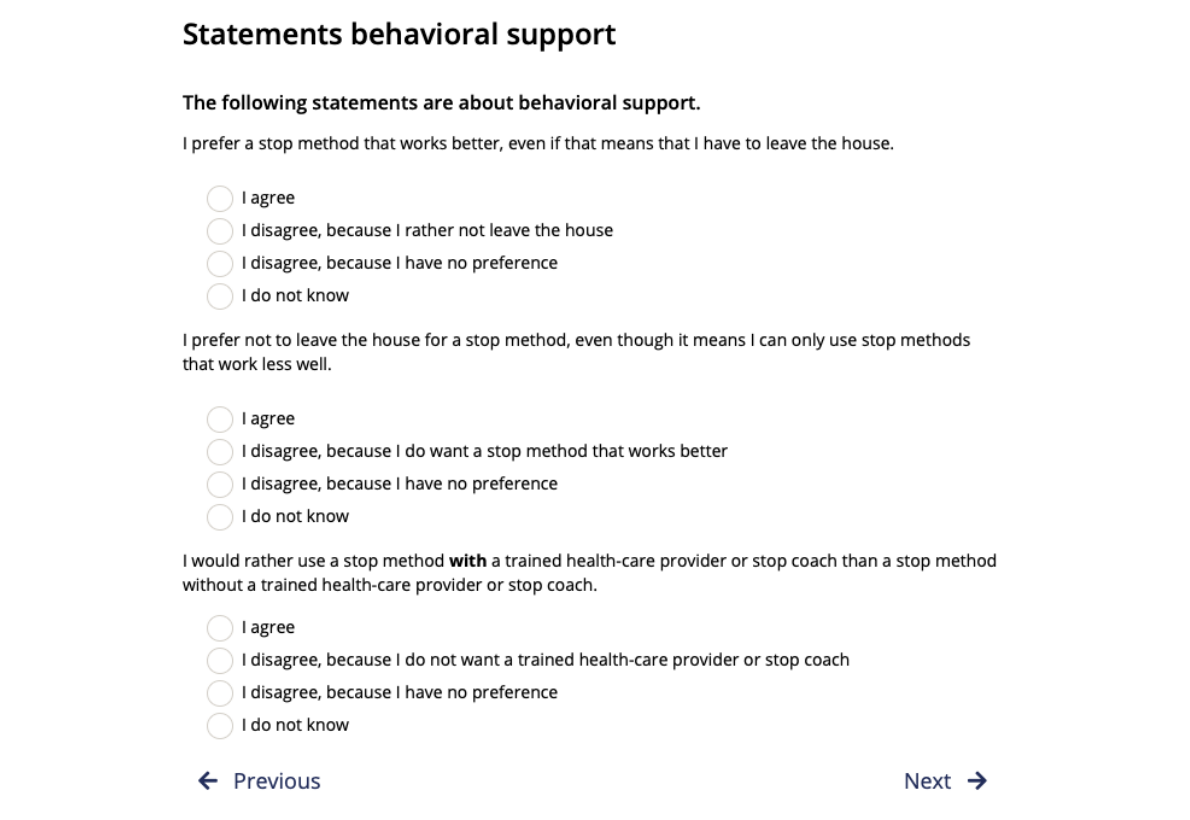
Figure 3. Screenshot of the value clarification method (VCM) in the decision aid (original text translated from